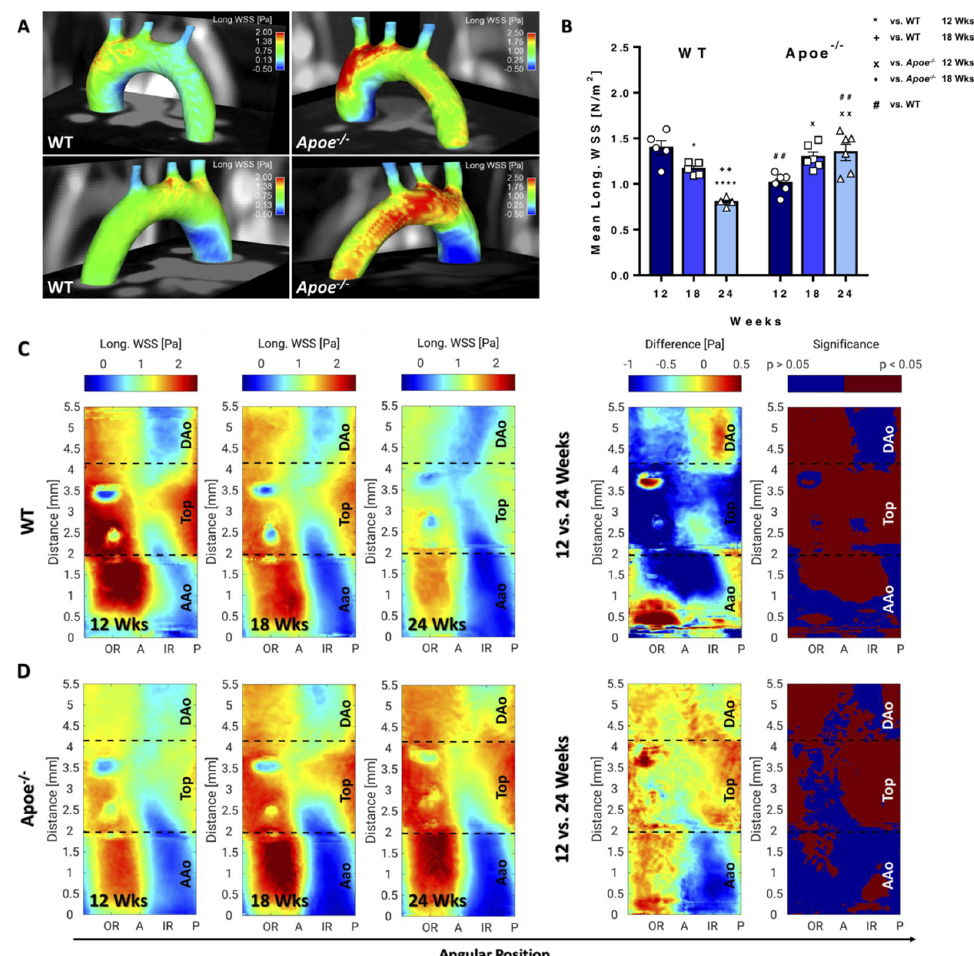
Figure 4. LongWSS increases in Apoe − / − mice during atherosclerosis progression but decreases in WT mice over time. ( A ) Three-dimensional longWSS map of a 24-week-old WT (left) and Apoe − / − mouse (right) from anterior and posterior view. A stronger WSS gradient was observed in Apoe − / − compared with WT mice and in the IR, lowered WSS is observable (dark blue spots). ( B ) Mean longWSS was decreasing in WT and increasing in Apoe − / − mice over time. * vs. WT 12 weeks, p < 0.05; **** vs. WT 12 weeks, p < 0.0001; ++ vs. WT 18 weeks, p < 0.01; x vs. Apoe − / − 12 weeks, p < 0.05; xx vs. Apoe − / − 12 weeks; # vs. WT, p < 0.05; ## vs. WT, p < 0.01. ( C ) LongWSS maps of WT mice (group average) for all measurement time points and statistical intragroup comparison of longWSS values (12 vs. 24 weeks), showing the difference maps of longWSS values and significance maps. ( D ) LongWSS Maps of Apoe − / − mice.